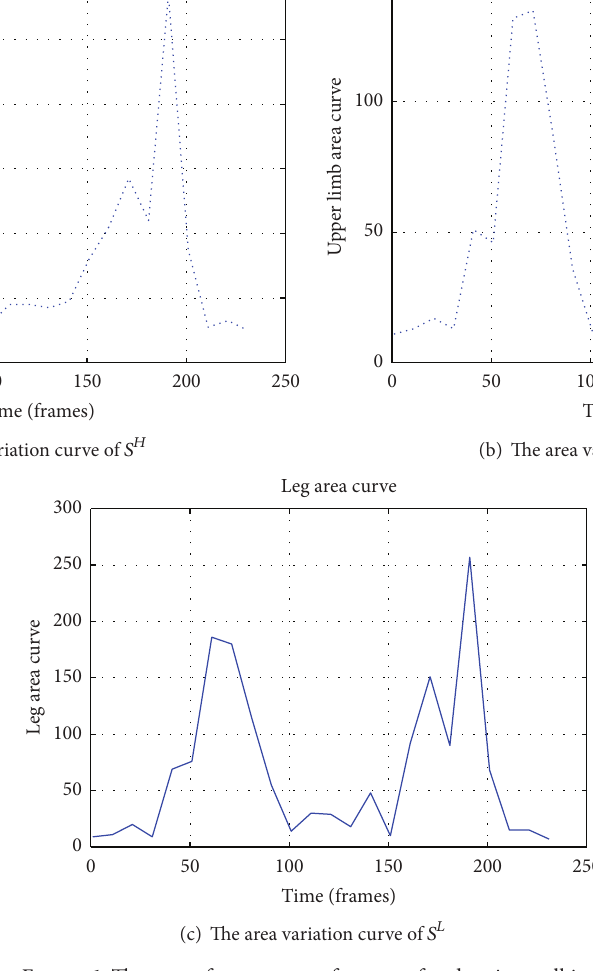
Figure 1: The curve for some area features of pedestrian walking. T5 : boxing, Δ V (the left foot, the left knee), Δ V (the right foot, the right knee), Δ V (the left foot, the left ankle), Δ V (the right foot, the right ankle) > 𝑡 8 and, Δ𝛼 (the left hand, the left elbow), Δ𝛼 (the right hand, the right elbow), Δ𝛼 (the left foot, the left ankle), and Δ𝛼 (the right foot, the right ankle) > 𝑡